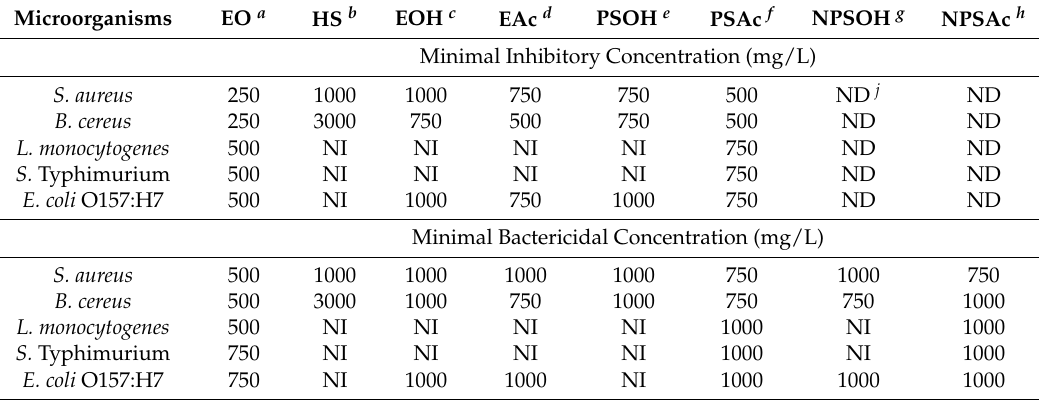
Table 3. Antimicrobial activity of P. longiflora Mexican oregano essential oil (EO), hydrosol, and extracts from waste solid residues, and the minimal inhibitory concentration and minimal cactericidal concentration